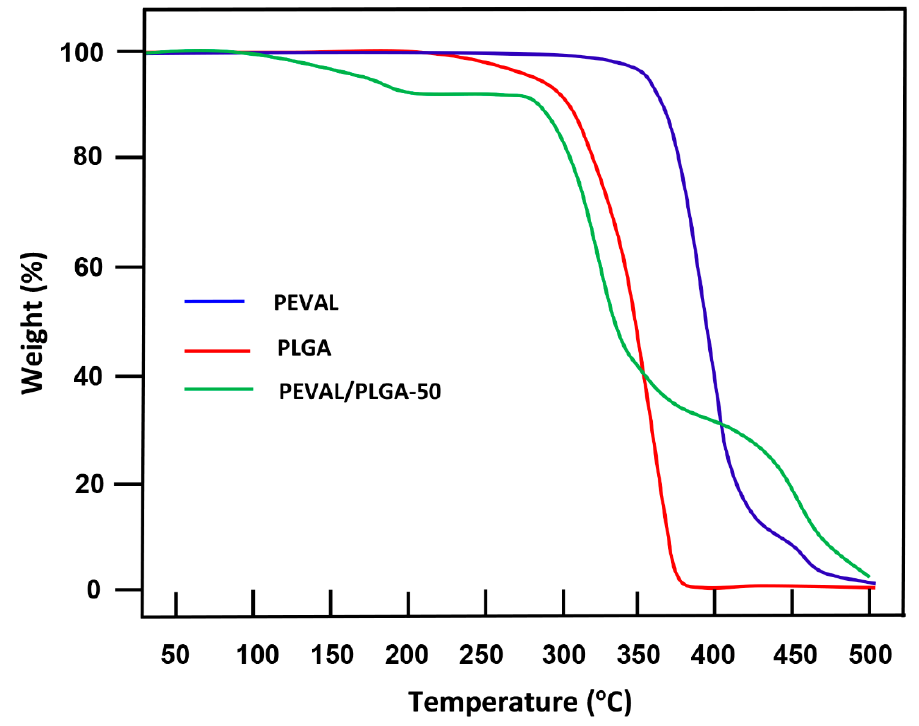
Figure 8. Thermograms TGA of pure PEVAL, PLGA, and their blend with equal